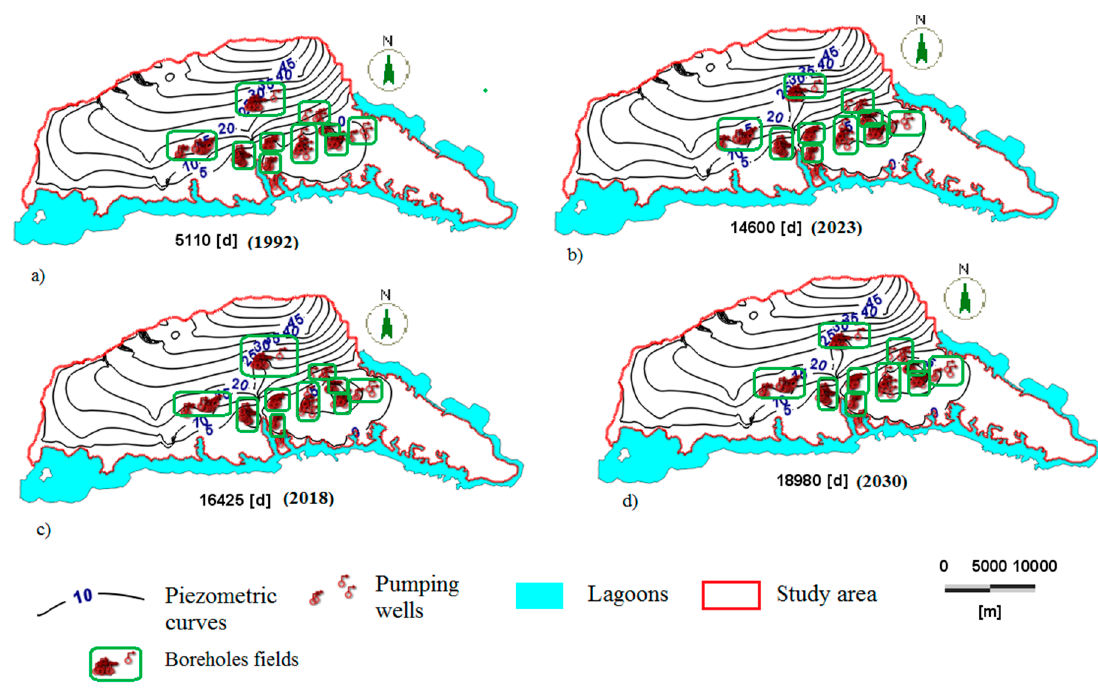
Figure 10. Simulated piezometric isolines (five-meter interval) ( a ) 1992, ( b ) 2018, ( c ) 2023, and ( d ) 2030. Table 3. Simulated drawdowns of the water table level from 1978 to 2030 at piezometer locations. Simulation (years) Drawdown of the Water Table (m) Piezometers Name